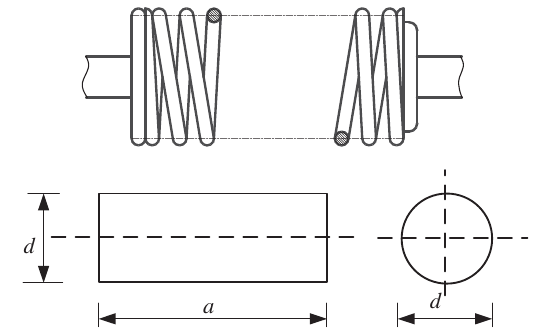
FIG. 5. A schematic diagram of helical inductor with windings W , length a , and diameter d .